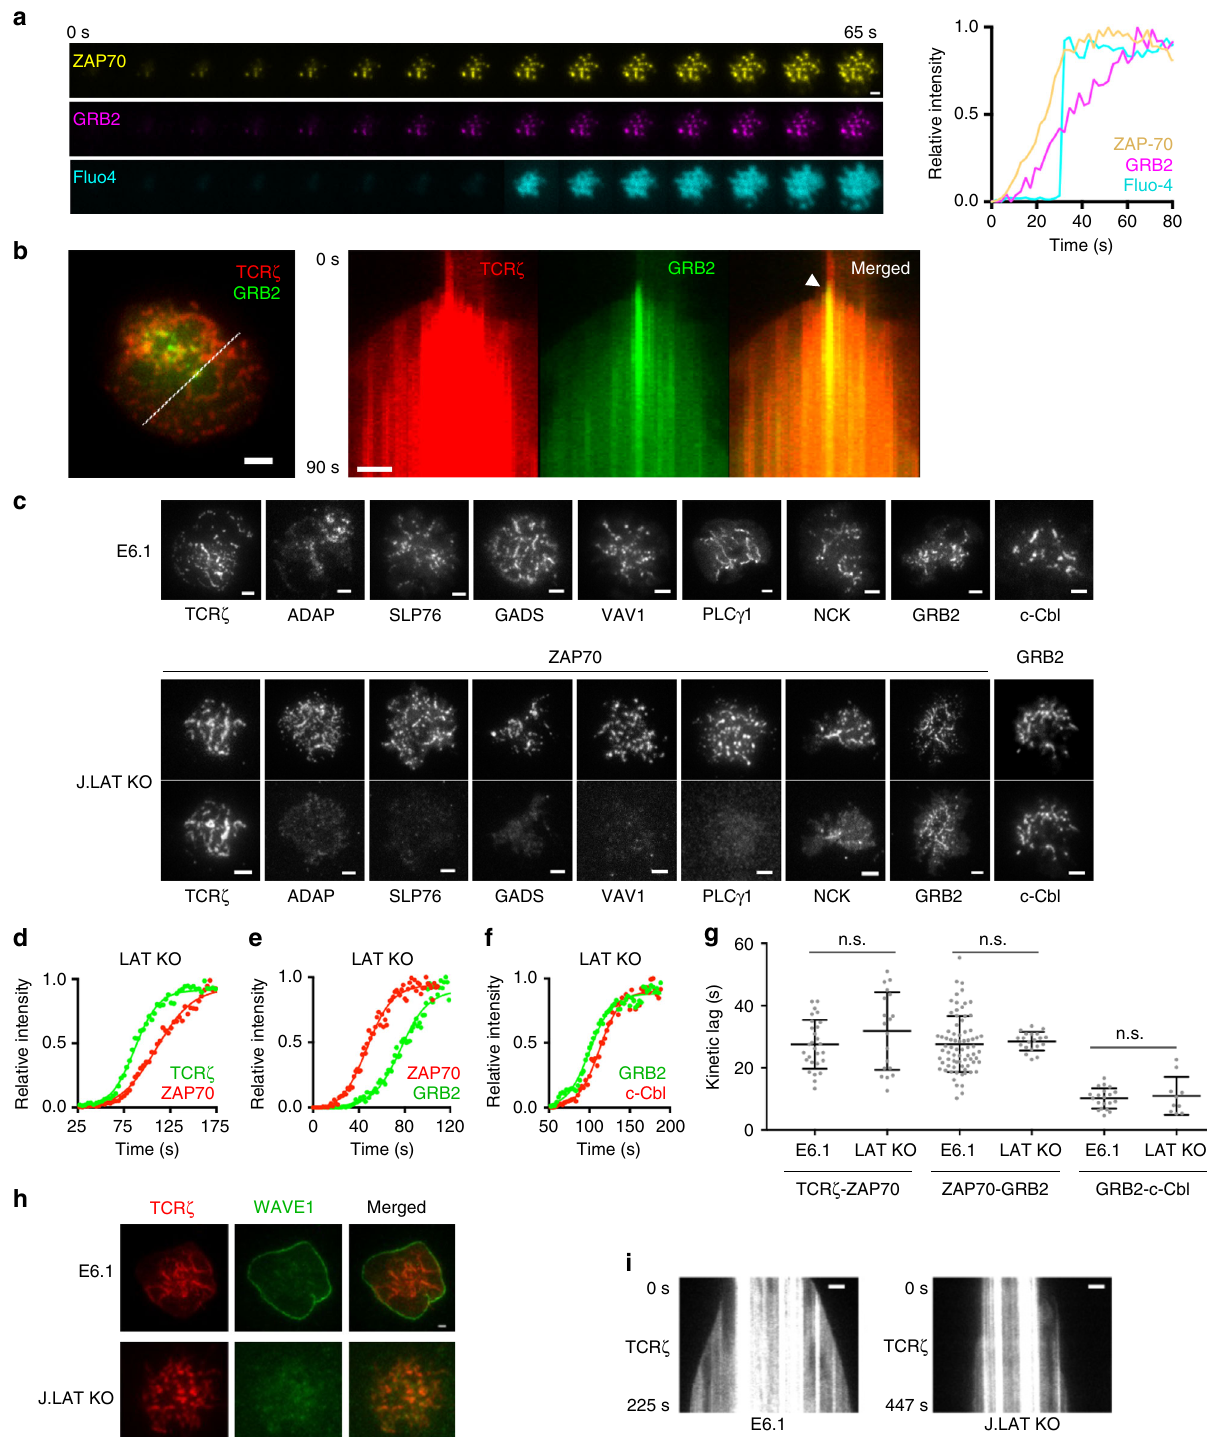
formation of a functional signaling domain, and for progression into downstream T cell activation pathways. Kinetic lag in microcluster recruitment is calcium-dependent . T cell activation begins with the formation of microclusters at focal contacts between T cell membrane protrusions and the activating surface, and is sustained by continued formation of microclusters at the periphery of the spreading cell 6,7 . As the early and late-formed microclusters differ both in geography